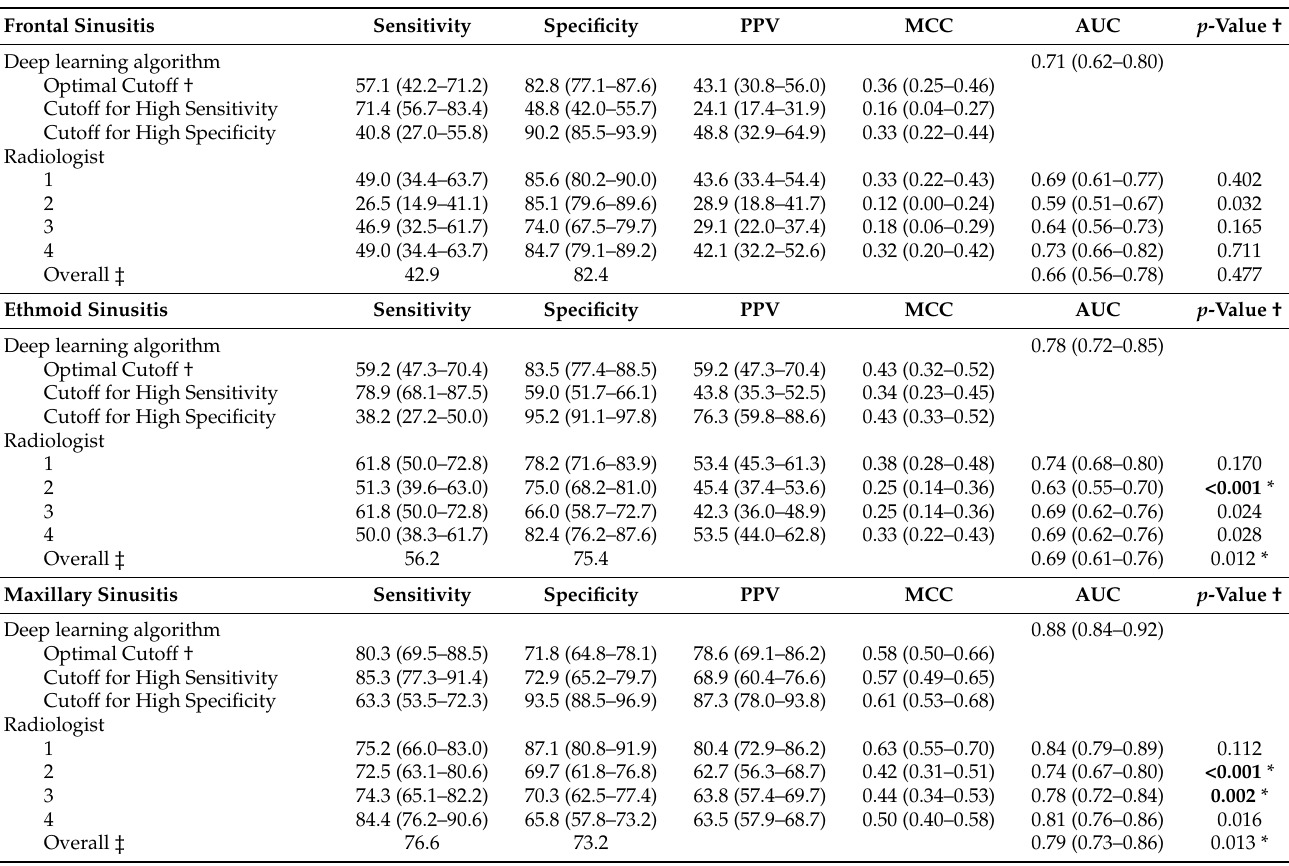
Table 3. Performance of deep learning model and radiologists in diagnosing multiple sinusitis.